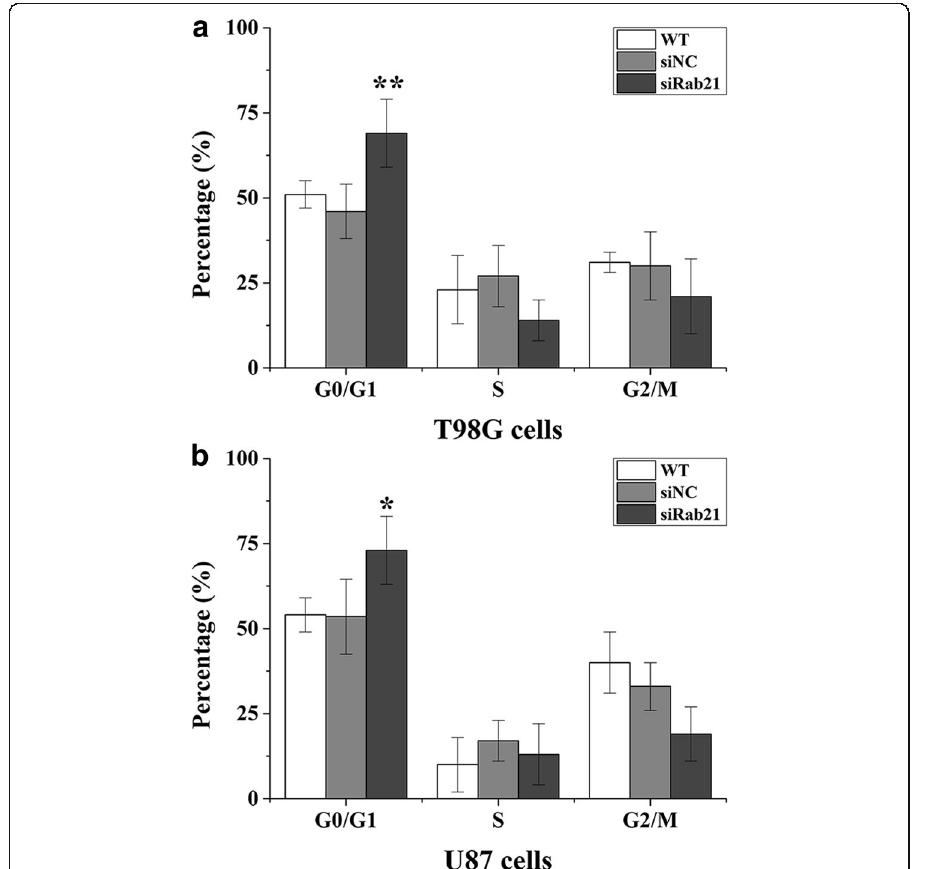
Fig. 4 Effect of Rab21 siRNA on cell cycle distribution in glioma cells. After transfection with Rab21 siRNA or Rab21-specific siRNA for 48 h, the cell cycle distribution of T98G ( a ) and U87 ( b ) cells was determined via flow cytometry. Representative images of cell cycle distribution alterations and cell percentages in different cell cycle phases after Rab21 knockdown are shown. * p < 0.05, ** p < 0.01 compared with siNC